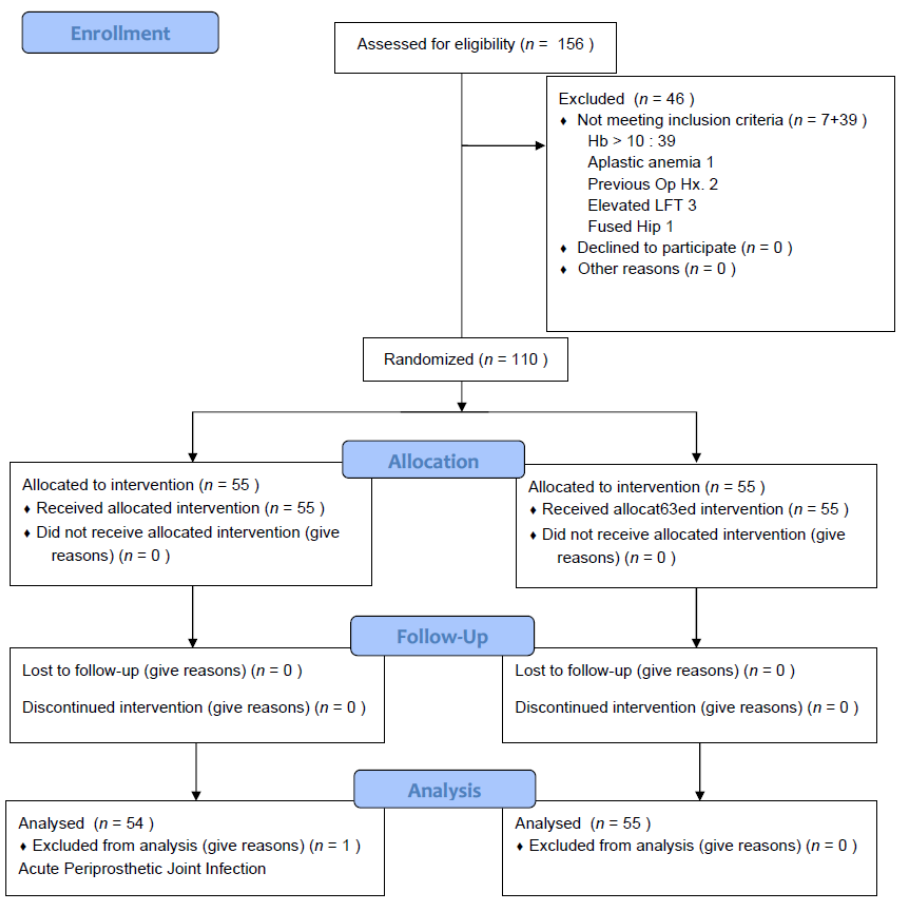
Figure 1. Consolidated Standards of Reporting Trials.